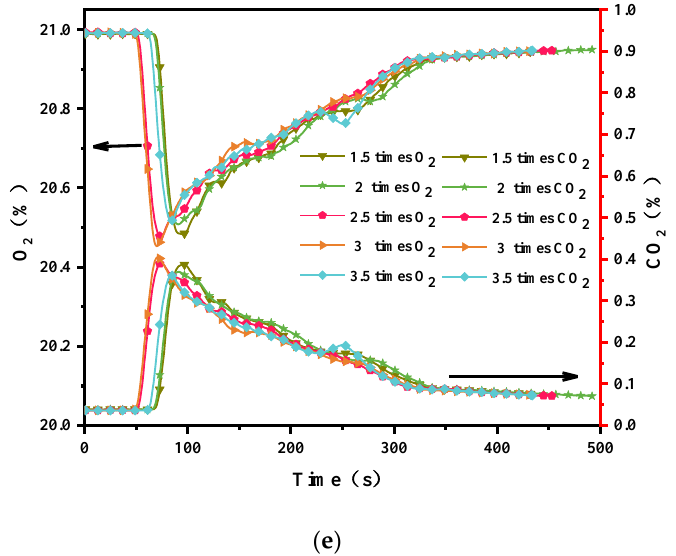
Figure 10. Evolution of the gaseous emissions at various heat fluxes. ( a ): 25 kW m −2 ; ( b ): 30 kW m −2 ; ( c ): 35 kW m −2 ; ( d ): 40 kW m −2 ; ( e ): 50 kW m −2 .